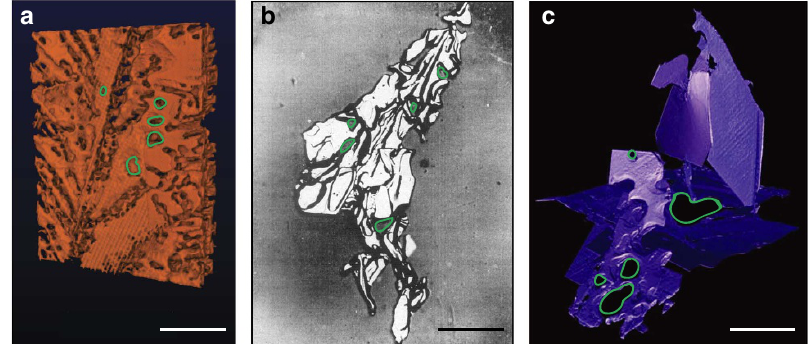
Figure 5 | Microstructure of the faceted phase in irregular eutectic alloys. In each of the three cases given, five representative gaps or holes are circled in green for clarity. ( a ) Front view of the eutectic colony showing the Ge phase in orange, this work. ( b ) Eutectic Si flake, extracted from a deep-etched Al-Si specimen by Hellawell 6 . The black lines correspond to multiple twin traces. Reproduced with permission from Elsevier 6 . ( c ) Eutectic Al 5 FeSi plates in an Al- Fe-Si alloy, the crystallization of which was imaged via in situ XRT by Terzi et al. 25 Reproduced with permission from Elsevier 25 . Scale bar 50 m m ( a ), 200 m m ( b ) and 150 m m ( c